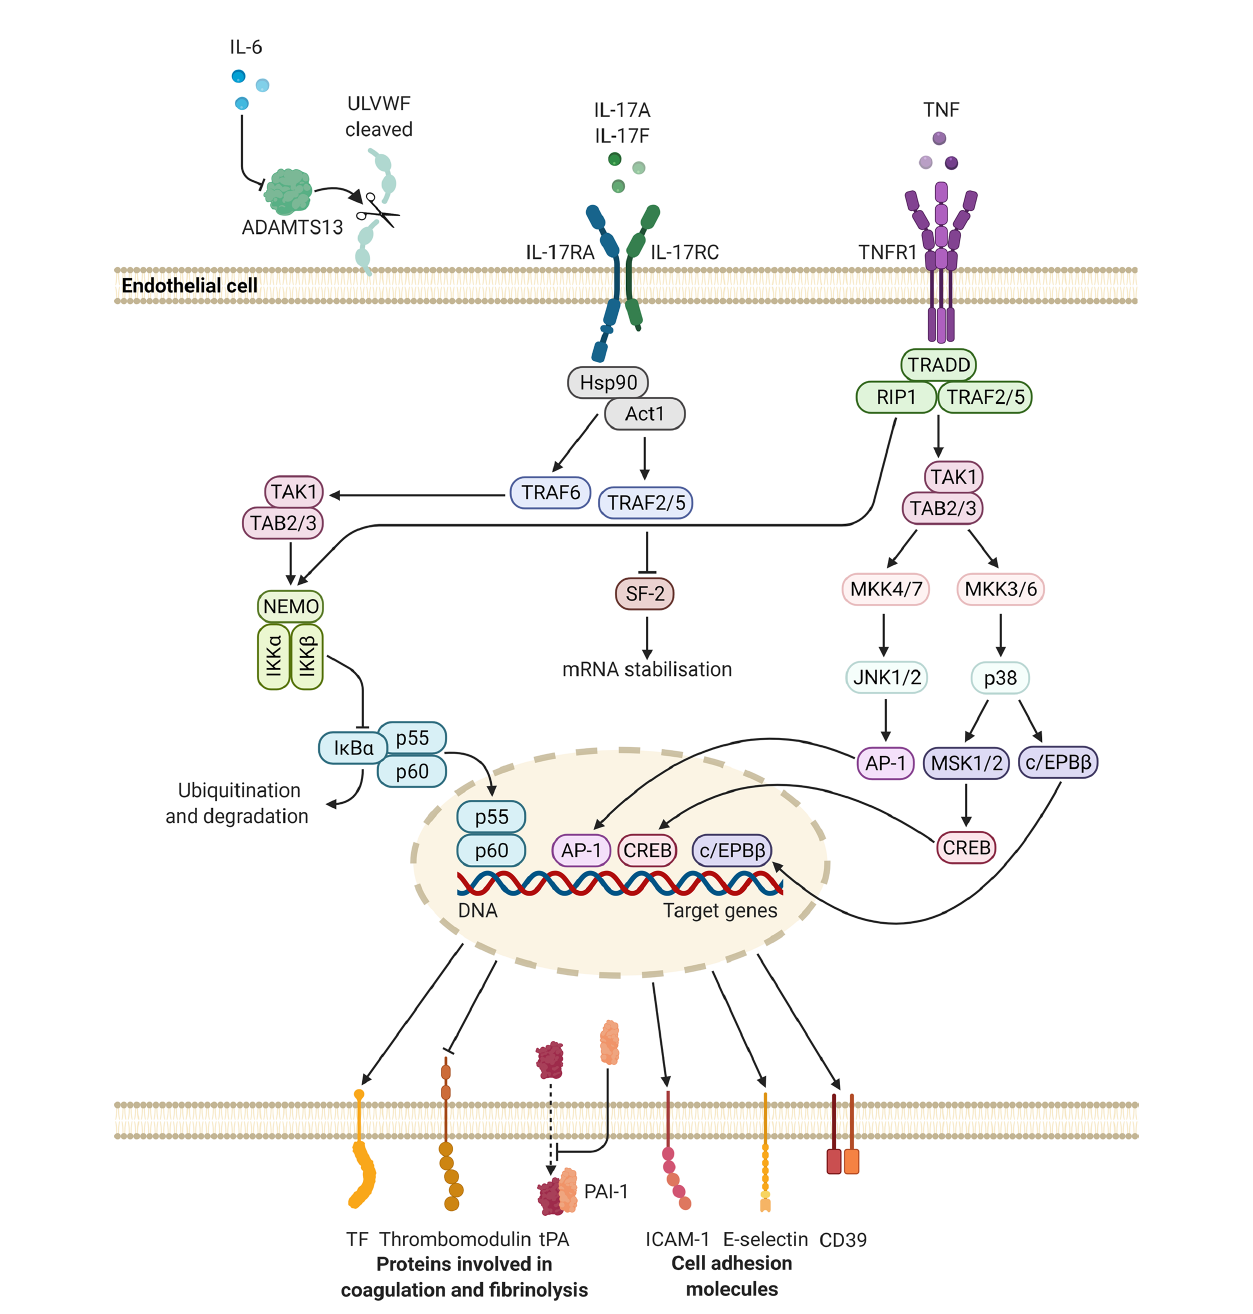
FIGURE 3 | Potential intracellular signalling pathways initiated in endothelial cells, upon stimulation with IL-6, IL-17, and TNF. These mediators may upregulate the synthesis and release of molecules that promote platelet adhesion and coagulation, while suppressing the expression of proteins involved in fi brinolysis. Altogether these changes may lead to a prothrombotic state. Diagram created with BioRender.com. ADAMTS13, a disintegrin-like and metalloprotease with thrombospondin type 1 motif, 13; AP, activator protein; c/EPB, CCAAT/enhancer-binding protein; CD, cluster of differentiation; CREB, cAMP response element binding protein; DNA, deoxyribonucleic acid; Hsp, heat shock protein; ICAM-1, intercellular adhesion molecule-1; IKB a , NF-kappa-B inhibitor alpha; IKK, inhibitor of nuclear factor kappa-B kinase; IL, interleukin; IL-17RA, interleukin-17 receptor A; IL-17RC, interleukin-17 receptor C; JNK, c-Jun N-terminal kinase; MKK, mitogen-activated protein kinase kinase; MSK, mitogen- and stress-activated protein kinase; NEMO, NF-kappa-B essential modulator; PAI-1, plasminogen activator inhibitor-1; SF, splicing factor; TF, tissue factor; TNF, tumour necrosis factor; TNFR, tumour necrosis factor receptor; tPA, tissue-type plasminogen activator; TRADD, tumour necrosis factor receptor 1-associated death domain protein; TRAF, tumour necrosis factor receptor-associated factor; RIP, receptor-interacting protein kinase; ULVWF, ultra-large von Willebrand